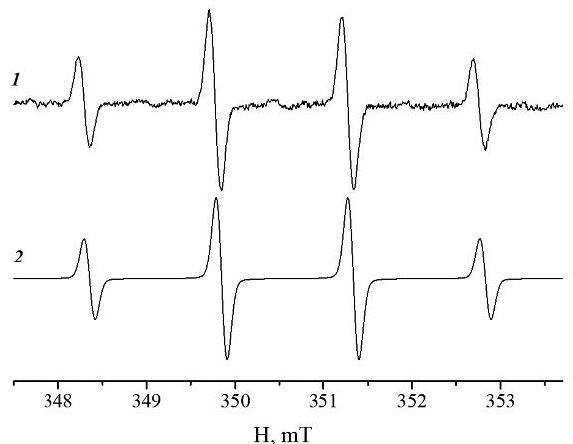
Figure 1. Experimental (1) and simulated (2) electron spin resonance spectra of the 5,5-dimethyl-1- pyrroline N-oxide (DMPO) spin adduct in an aqueous solution containing iron oxide nanoparticles (IONPs) and the hydrogen peroxide. The simulated spectra of the spin adducts were obtained using hyperfine coupling constants a N = 1.49 mT and a H = 1.50 mT from [37]. HSA was purchased from Sigma (A1653). The aqueous HSA solution with a protein concentration of 100 mg/mL was added as 10 vol.% to the 10-fold diluted IONP hydrosol immediately under stirring on a Vortex V-1 plus (Biosan, Riga, Latvia). The C HSA /C IONPs ratio was 10 [mg/mg]. According to the procedures we discussed elsewhere [30,36], hydrogen peroxide solution (>30%) (95321, Sigma-Aldrich, St. Louis, MO, USA) was diluted in water to be added as 3.0 vol.% to the solutions containing HSA and IONPs in a C H2O2 /C IONPs ratio [mg/mg] equal to 1/1 and incubated in a Rotator Multi Bio